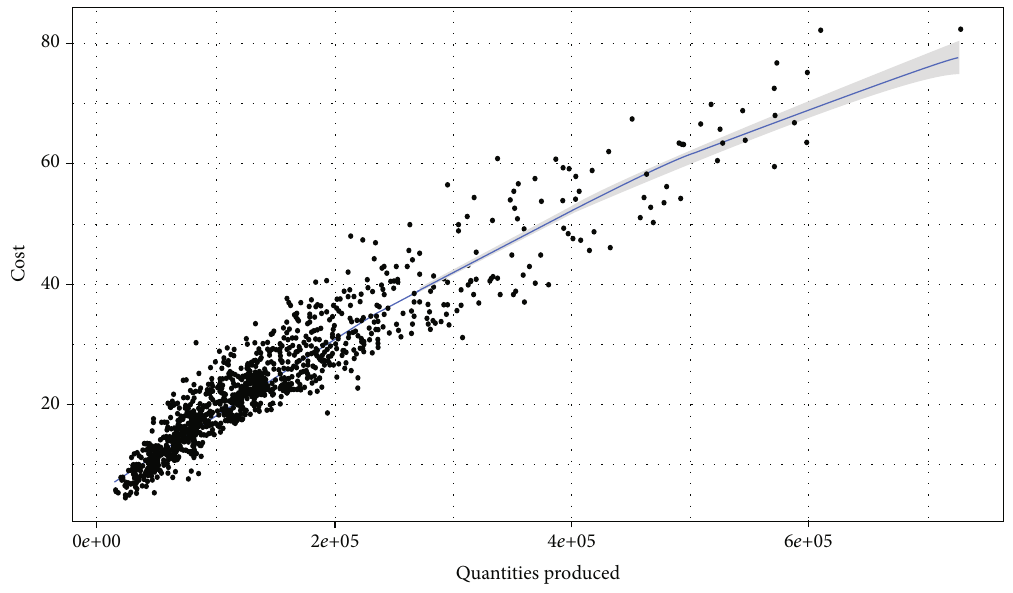
Figure 5: The cost function of milk production. Table 2: Estimation of the cost function coe ffi cients by linear